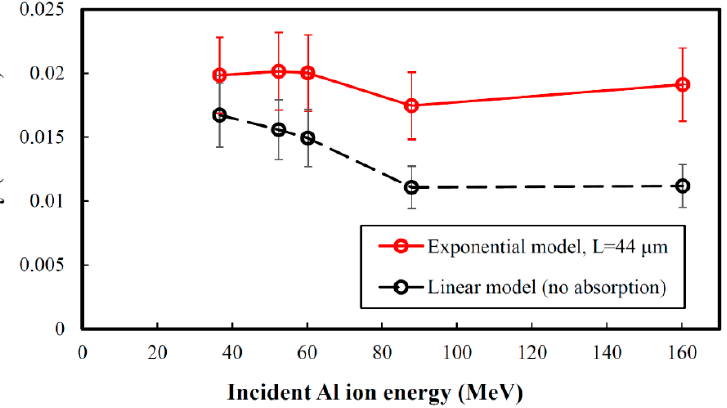
Figure 5. Sensitivity of BAS-TR IP is shown as a function of the incident Al ion energy on the IP surface.